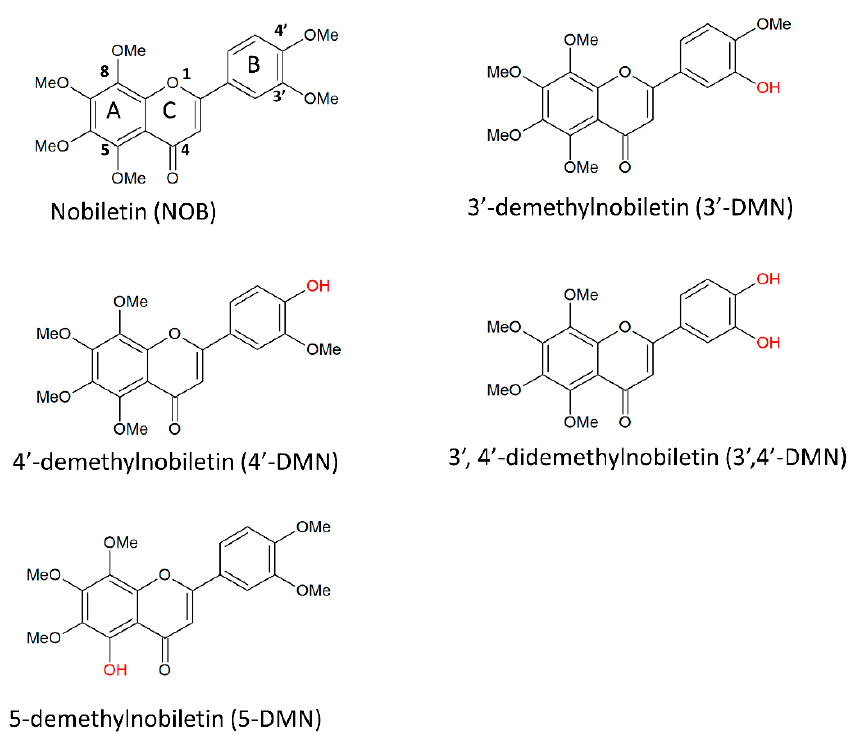
Figure 1. Chemical structures of nobiletin and its derivatives.